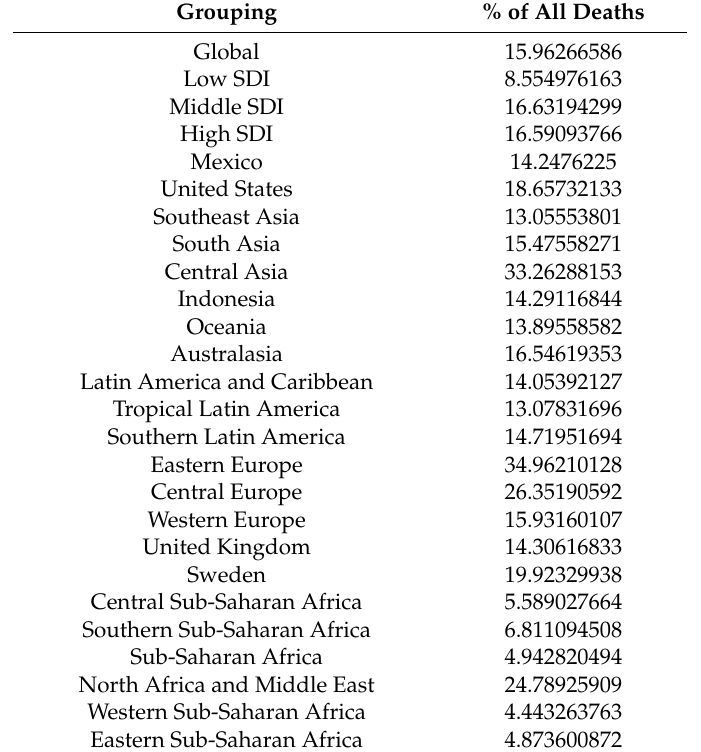
Table 1. Ischemic heart disease related deaths in select demographics [5]